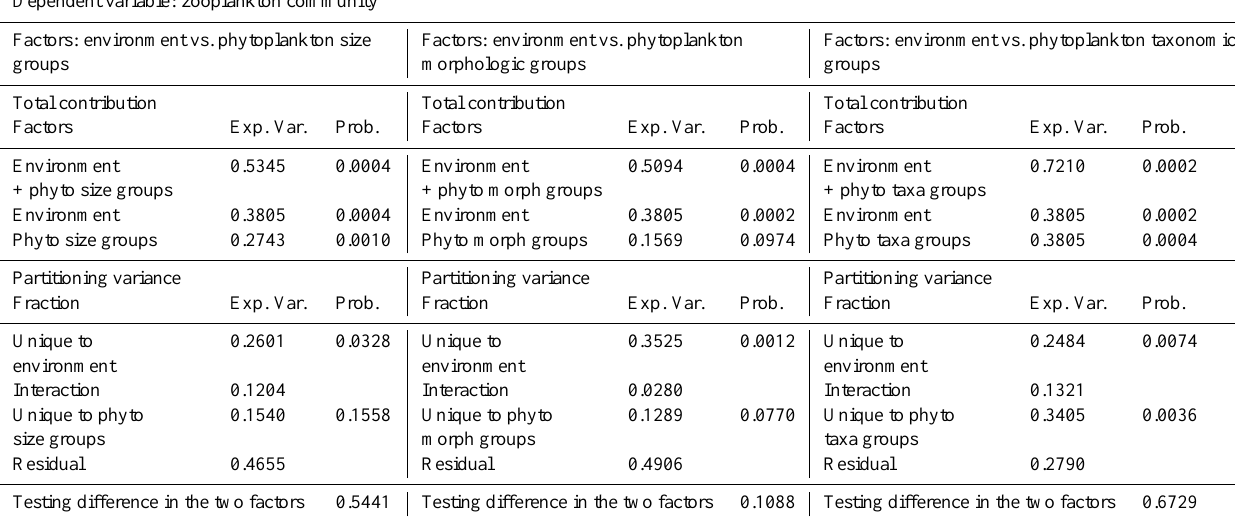
Table 4. Results of variance partition to investigate the relative contribution of environmental and phytoplankton matrices in explaining the variation of zooplankton community based on genus